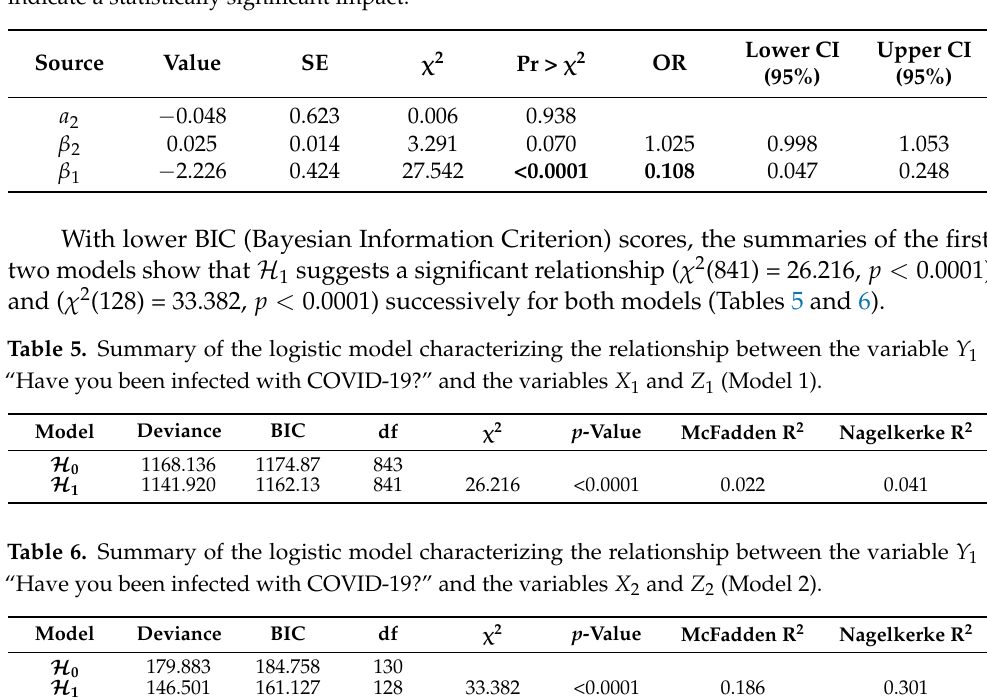
Figure 2. Relationship charts between the dependent variable 𝑌 (cid:2869) and the two explanatory variables. 𝑋 (cid:2869) , 𝑋 (cid:2870) . 3.2.2. Relationship between Preventive Measures and Vaccination as Characterized by COVID ‐ 19 Treatment The association between the dependent variable 𝑌 (cid:2870) “Have you taken any COVID ‐ 19 treatment? (Medicinal, natural, preventive, prescribed...)” based on the variables 𝑋 (cid:2869) (those who use preventive measures without vaccination versus those who do not use preven ‐ tive measure without vaccination) and 𝑍 (cid:2869) (age for both groups of the dichotomous varia ‐ ble) was studied. Furthermore, we also studied the relationship between the same de ‐ pendent variable 𝑌 (cid:2870) based on the variables 𝑋 (cid:2870) (people who apply preventive measures and are vaccinated versus people who do not apply preventive measures and are vac ‐ cinated) and 𝑍 (cid:2870) (age of the individuals in this variable). Both models were put into the following form: ⎩⎨⎧𝑃(cid:4666)𝑌 (cid:2870) (cid:3404) 1 (cid:4667) (cid:3404)